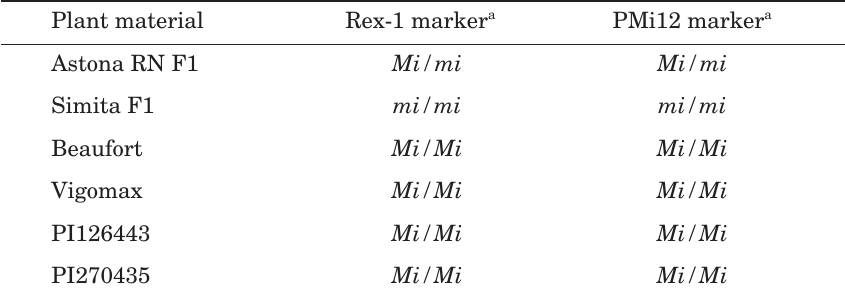
Table 2. Molecular marker analysis of the Mi